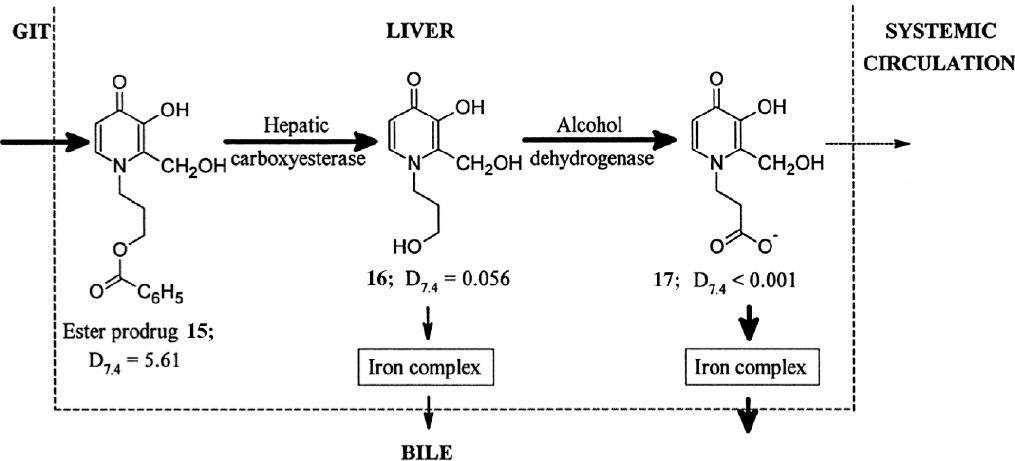
Figure 5. Schematic representation of the use of hydrophobic esters to enhance both the absorption from the gastrointestinal tract (GIT) and the hepatic extraction of the chelator. Subsequent intracellular hydrolysis occurs yielding a hydrophilic chelator which can undergo further metabolism to the extremely hydrophilic negatively charged 1-carboxyalkyl metabolite in the liver. Reprinted with permission from Liu, Z.D.; et al. Synthesis, physicochemical characterisation, and biological evaluation of 2-(1 ′ -hydroxyalkyl)-3-hydroxypyridin-4-ones: Novel iron chelators with enhanced pFe 3+ values. J. Med. Chem. 1999 , 42 , 4814–4823. Copyright American Chemical Society. Table 3. Protonation constants and Fe 3+ stability constants for 3,4-HP derivatives.